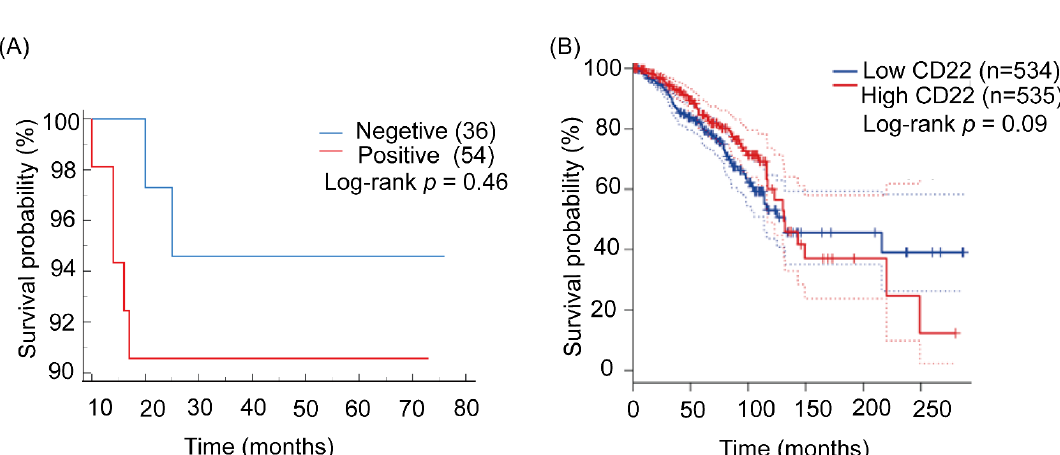
Figure 4. Correlation analysis of CD22 expression and overall Survival of TNBC patients ( A ) Correlation analysis of overall survival of TNBC patients and CD22 expression. ( B ) Survival plots for CD22 expression and breast cancer patients from GEPIA showed no significant association between both. The solid lines represent survival curve, and the dashed lines represent 95% confidence intervals.